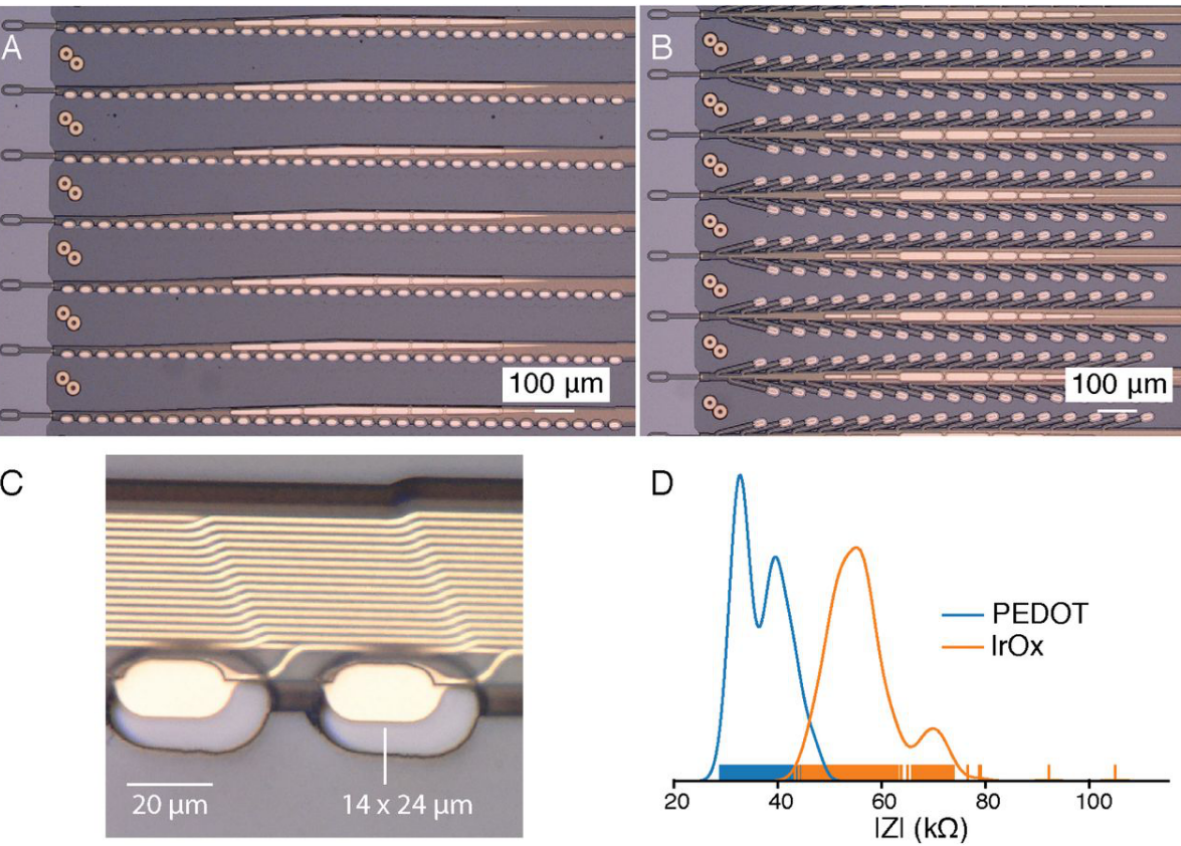
Figure 1. Our novel polymer probes. (A) “Linear Edge” probes, with 32 electrode contacts spaced by 50 μm. (B) “Tree” probes with 32 electrode contacts spaced by 75 μm. (C) Increased magnification of individual electrodes for the thread design in panel A, emphasizing their small geometric surface area. (D) Distribution of electrode impedances (measured at 1 kHz) for two surface treatments: PEDOT (n=257) and IrOx (n=588). IrOx: iridium oxide; PEDOT: poly-ethylenedioxythiophene; PCB: printed circuit